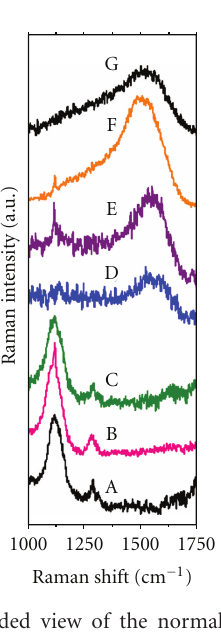
Figure 3: The Raman spectra of unimplanted (specimen A) and fluorine-ion-implanted (specimens B to G) B 6 O specimen. The spectra are shifted along the y -axis for better comparison. The y - axis is normalized.